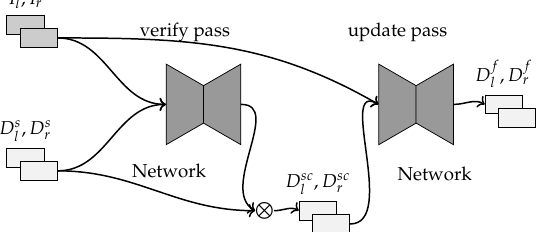
Figure 15. The inputs shown are the left–right RGB images I l , I r and the left–right sparse disparity maps D s , D s r . After the verify pass, the filtered disparity maps are computed D sc l disparities that are not consistent. After the update pass, the fused disparity maps are computed D f , D f r l